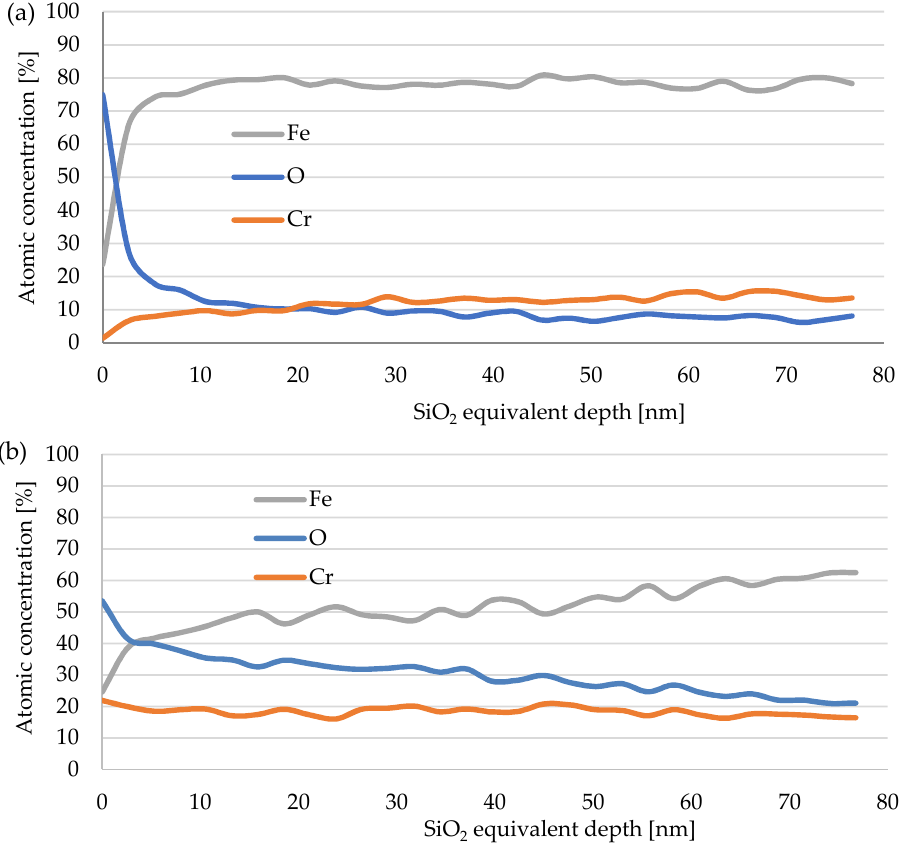
Figure 6. Depth profile analysis of SUS 304 stainless steel. ( a ) Room temperature, ( b ) annealed at 700 ◦